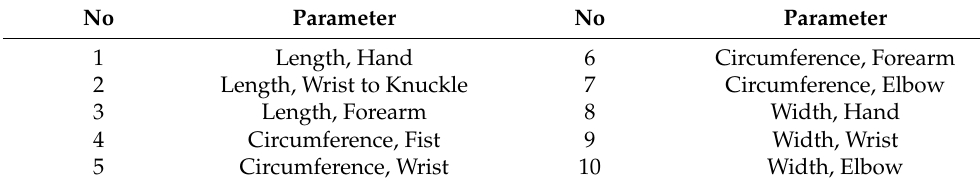
Table 1. Selected body segment parameters (BSP).